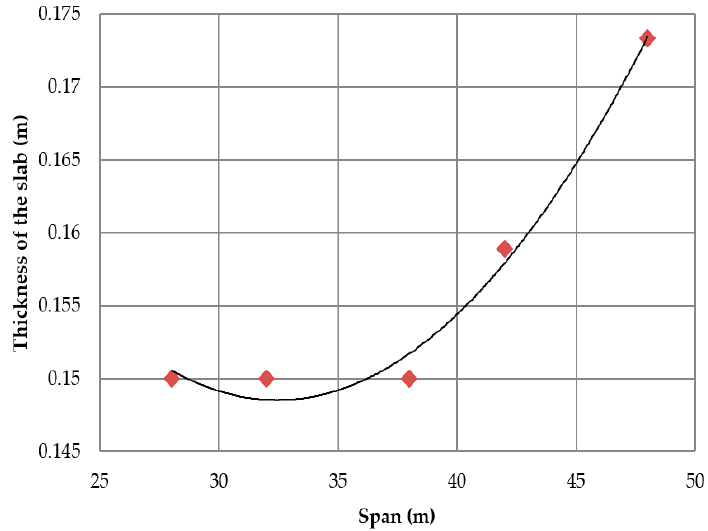
Figure 10. Mean slab thickness for different span lengths. 351